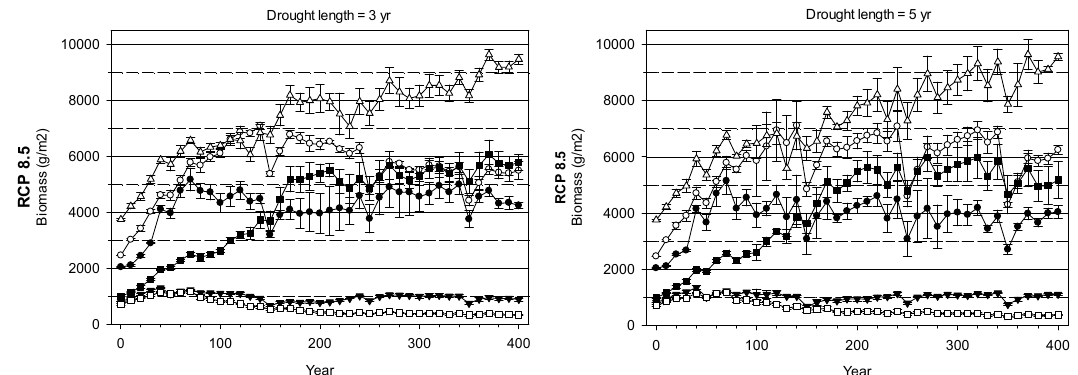
Figure 7. The effect of climate ( rows ) and drought length ( columns ) on productivity (mean species biomass) by forest type groups. Mixed swamp conifers and mixed oaks were very uncommon and are not shown. Error bars show one standard deviation.